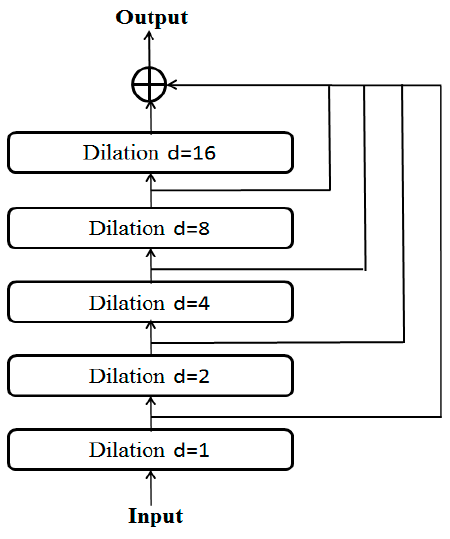
Figure 3. Detailed diagram of the dilated residual